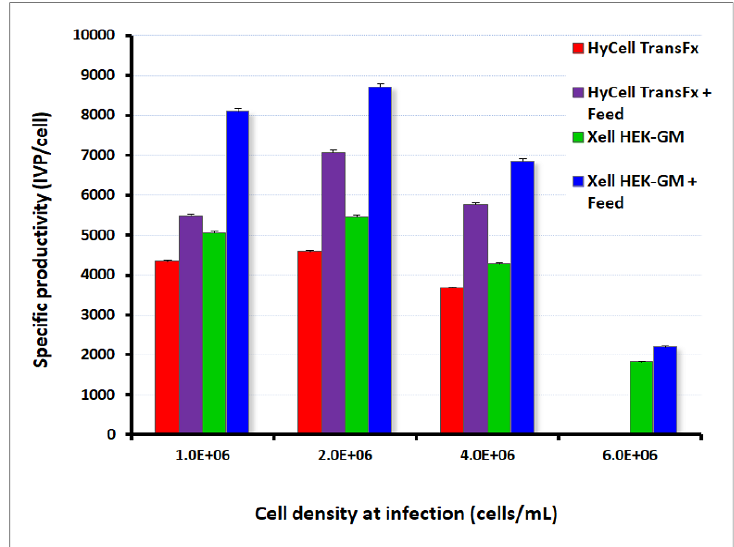
Figure 3. Adenovirus production in shake flasks experiments and evaluation of cell culture parameters and infection conditions for increased virus per cell production yields: Infection experiments